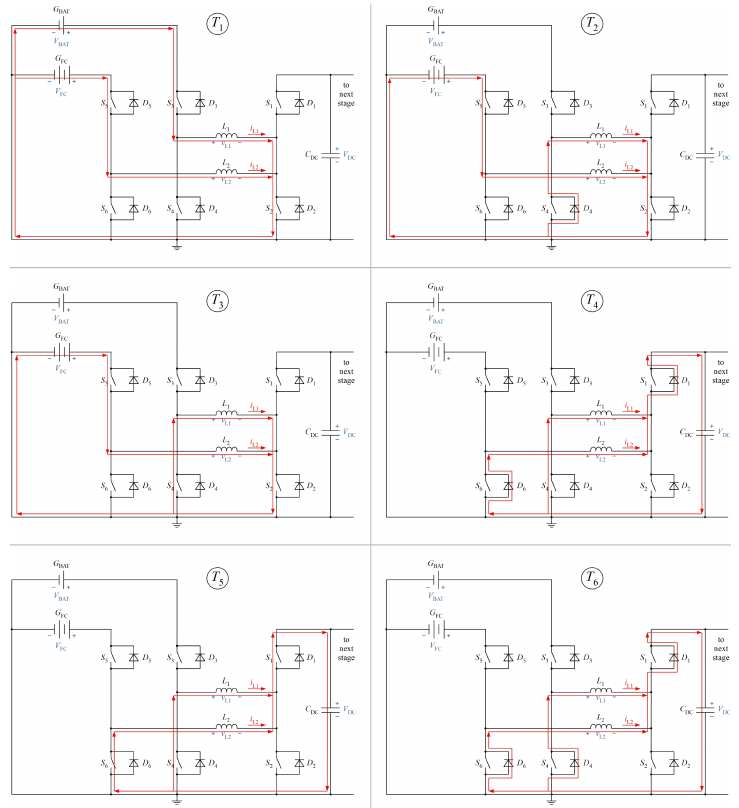
Figure 15. Current flow in BFC2DC mode during time intervals T 1 – T 6